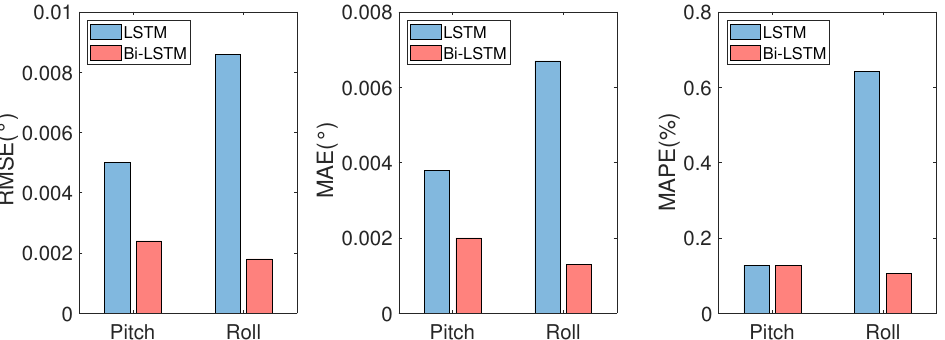
Figure 6. Error statistical histogram of USV attitude angle